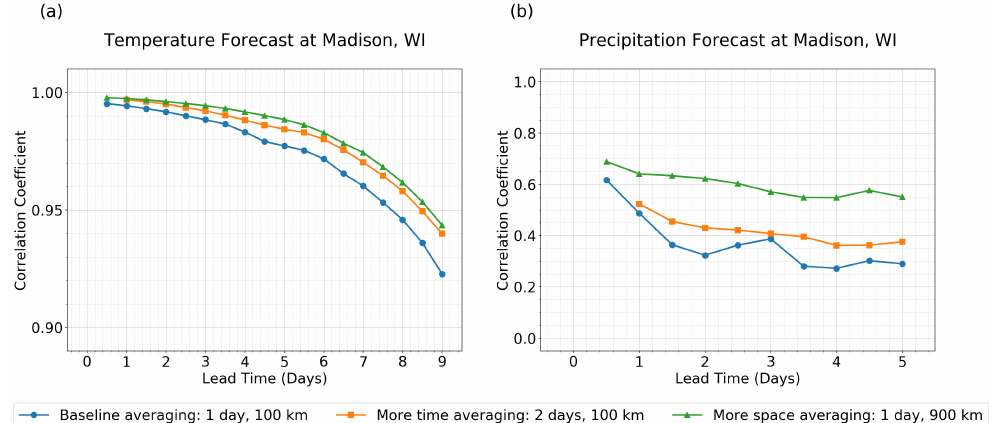
Figure 2. Effects of time averaging and space averaging on forecast performance, at the location of Madison, Wisconsin, USA, for ( a ) temperature forecasts and ( b ) precipitation forecasts. For temperature, forecast performance is improved by approximately the same amount for either the additional time averaging or the additional space averaging. On the other hand, for precipitation, the additional spatial averaging brings a much larger improvement in forecast performance than the additional time